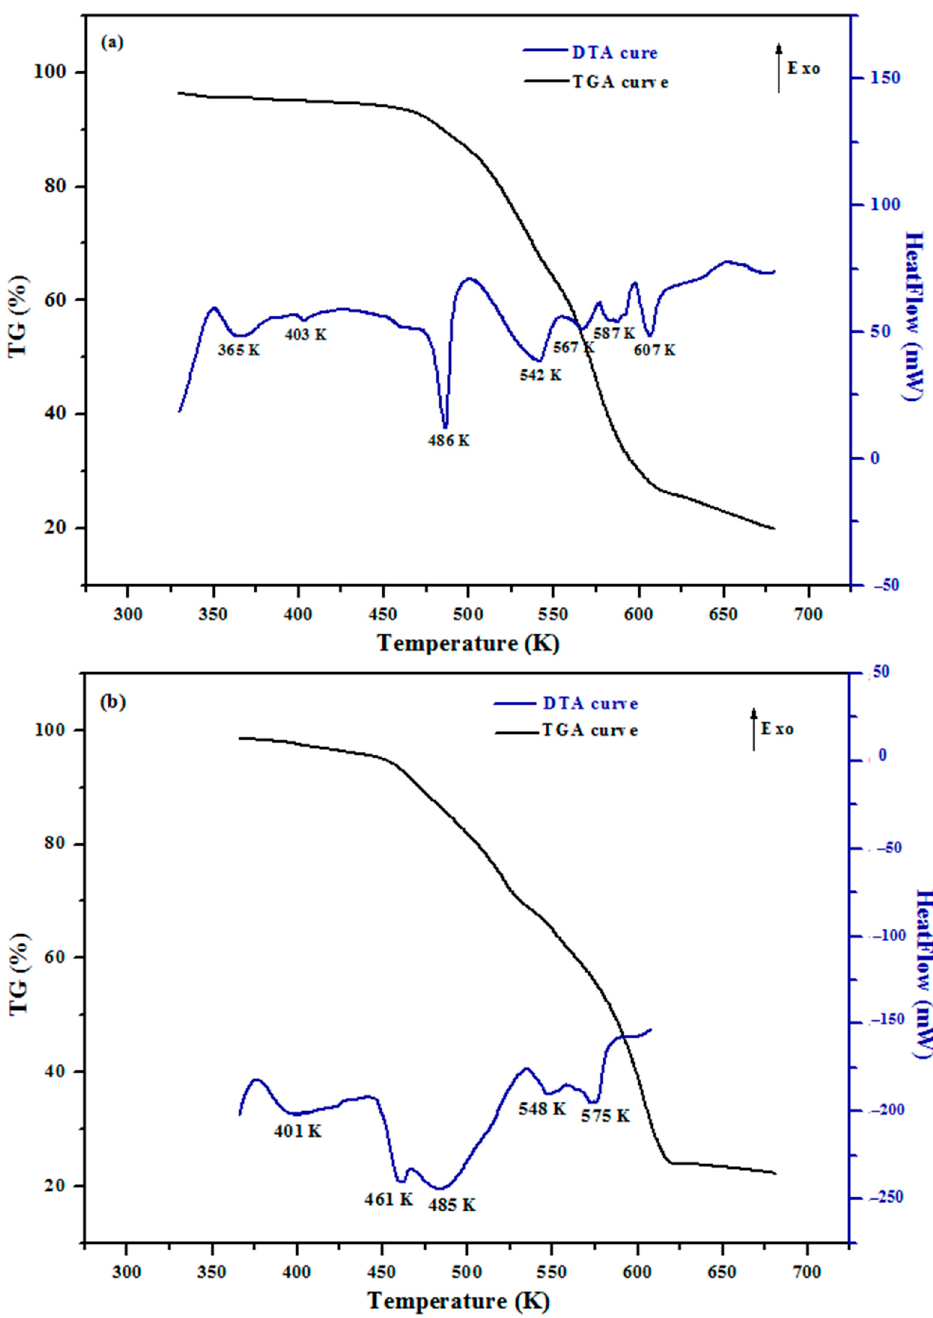
Figure 10. ( a ) TG and DTA curves of [C 9 H 14 N] 2 [MnCl 4 ]. ( b ) TG and DTA curves of [C 9 H 14 N] 2 [CoCl 4 ]. Figure